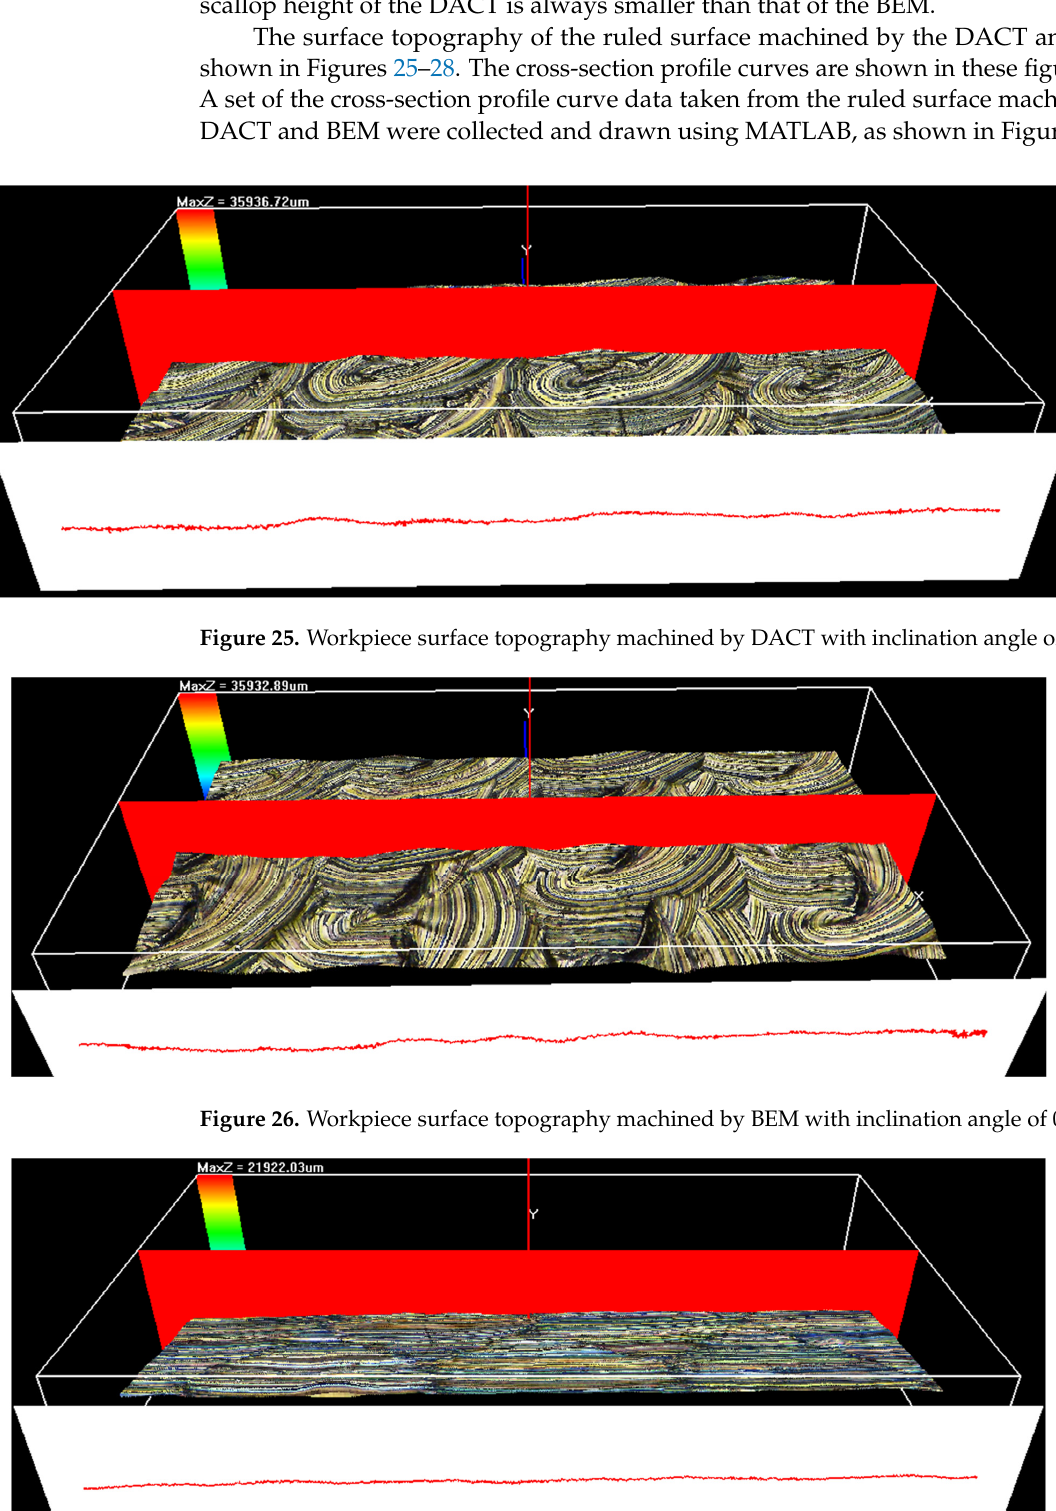
( f ) Figure 24. Comparison of workpiece surface between DACT and BEM: ( a ) surface machined by DACT with inclination angle of approximately 10°; ( b ) surface machined by BEM with inclination angle of approximately 10°; ( c ) surface machined by DACT with inclination angle of 0°; ( d ) surface machined by BEM with inclination angle of 0°; ( e ) surface machined by DACT with inclination angle of approximately 20°; ( f ) surface machined by BEM with inclination angle of approximately 20°.